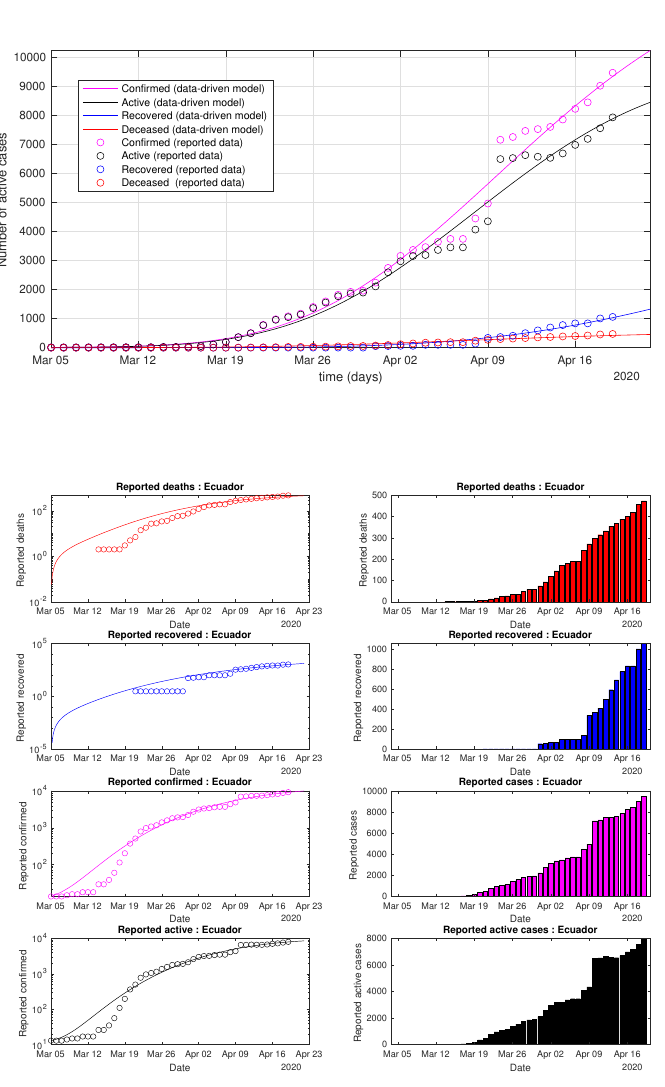
Figure 25. Ecuador: data of active, recovered, deceased (in circle or bar) vs. model of active, recovered, deceased over time. Tracking the number of active cases. Predictive analytics for the next couple